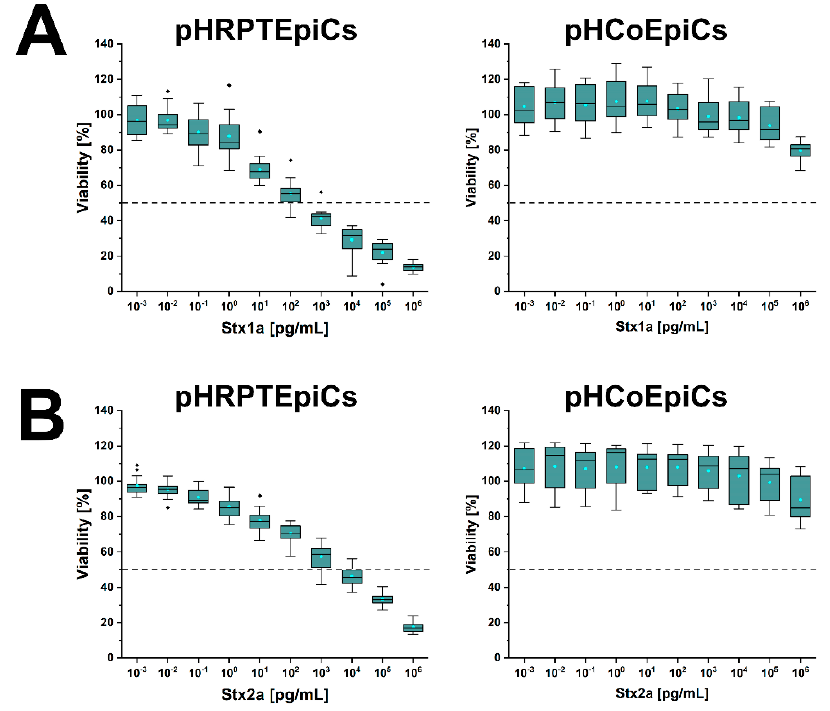
Figure 7. Cytotoxic response of pHRPTEpiCs and pHCoEpiCs upon exposure to increasing concentrations of Stx1a ( A ) and Stx2a ( B ). The cell-damaging effect was determined with the crystal violet assay, and the absorption readouts of Stx1a- and Stx2a-treated cells are displayed as box plots. The extent of cell damage is given as percentage values related to untreated cells, which represent 100% viable cells. For further details refer to Detzner and collaborators [193,194], where the data were taken from.